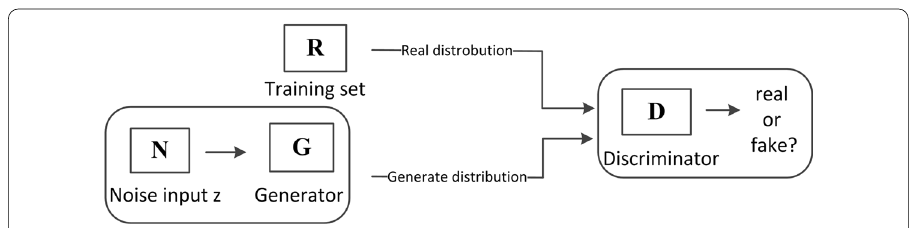
Fig. 1 Schematic diagram of classical generative adversarial